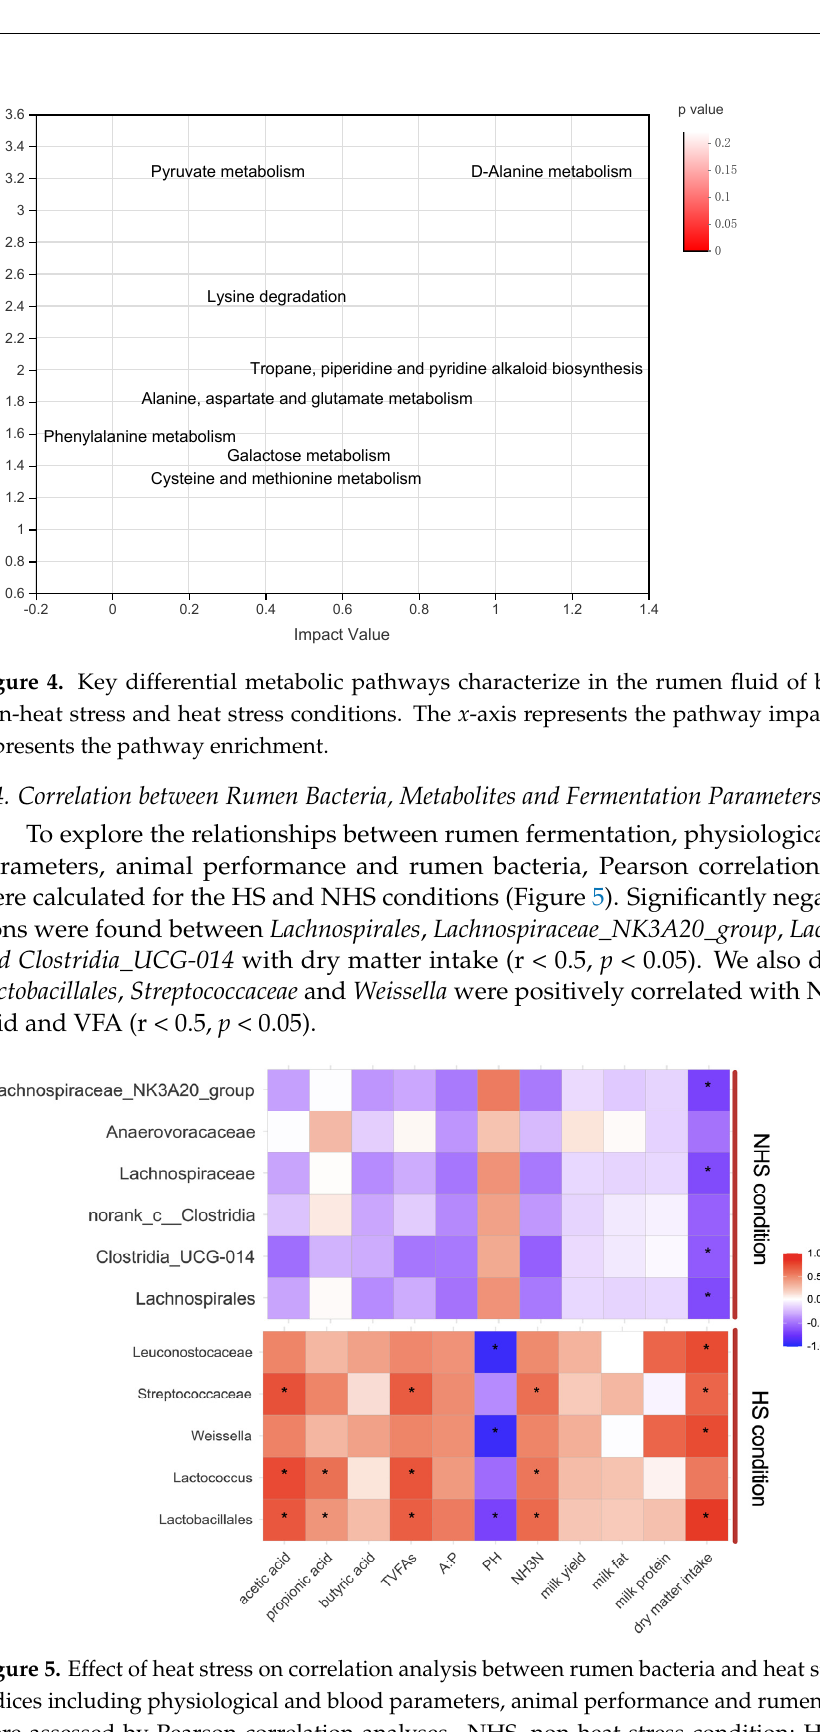
Figure 3. Differential metabolites in rumen fluid of buffalo under non-heat stress and heat stress conditions. The heatmap is the metabolite expression and the right side is the metabolite variable importance in projection (VIP) bar graph. The color of the bar indicates the significance of the dif- ference between the two groups of metabolites, * represents p < 0.05, ** represents p < 0.01, *** rep- resents p < 0.001. N, non-heat stress condition; H, heat stress condition.